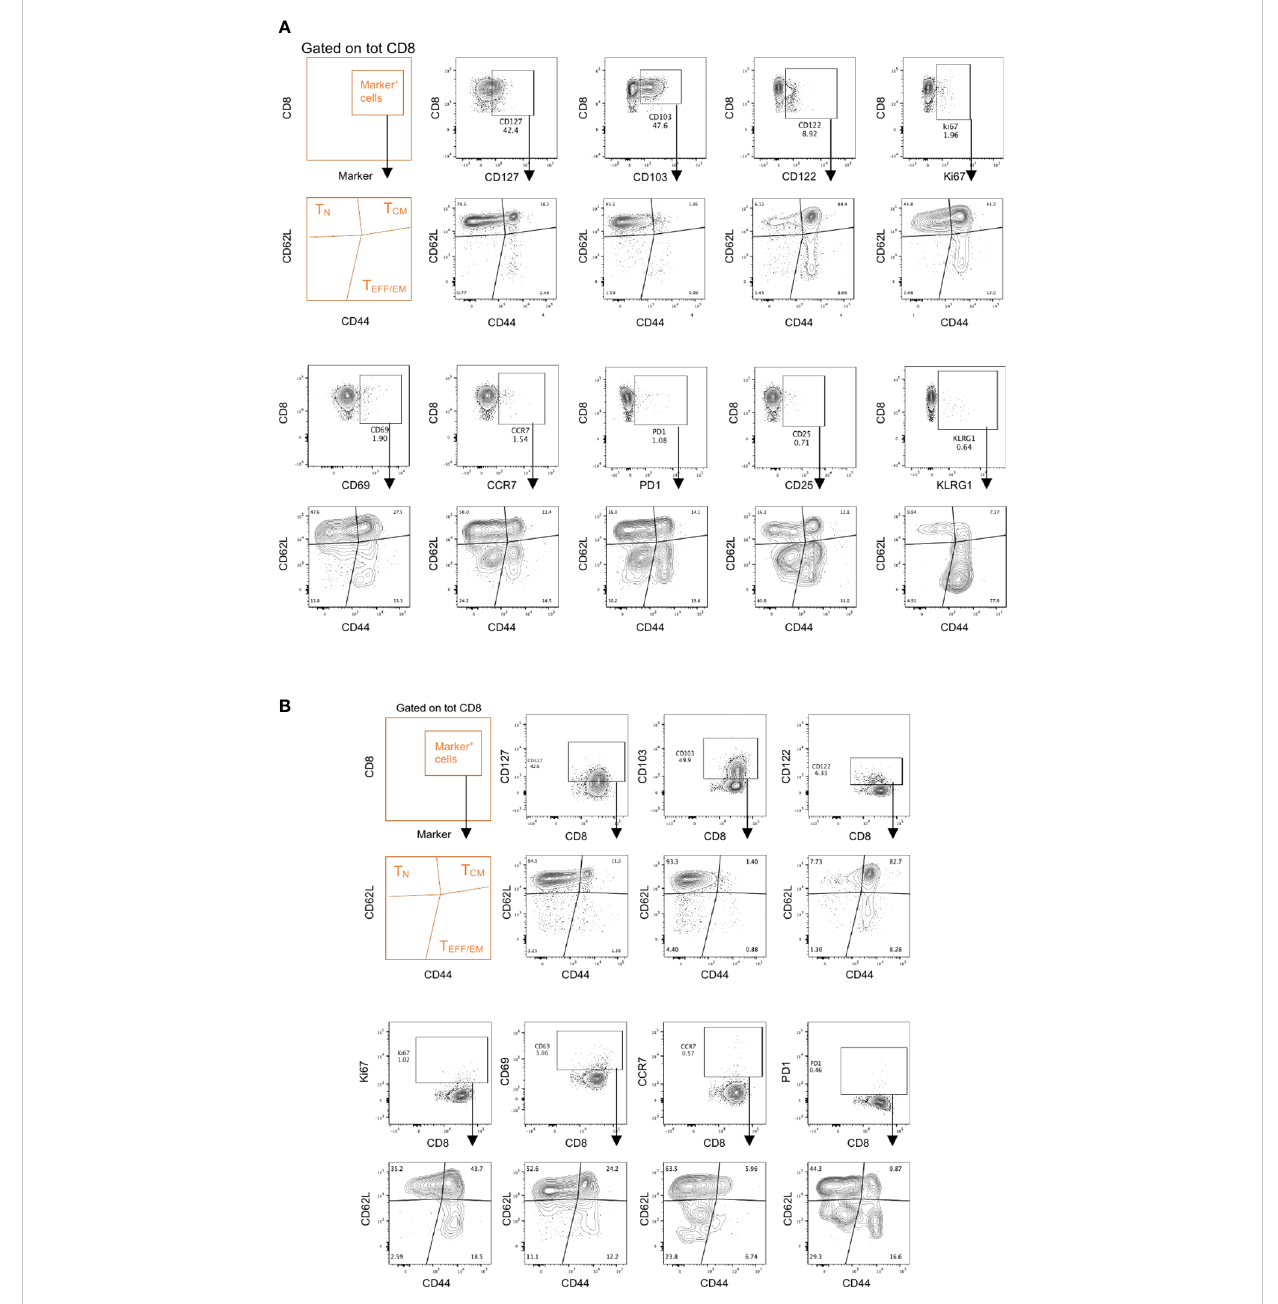
FIGURE 4 Memory effector phenotypes in Panel 2. Spleens and draining lymph nodes isolated from C57Bl/6 mice bearing YUMM UV 1.7 melanomas were processed and stained with Panel 2 as described in methods. (A, B) Representative analysis on CD8 + T cells from spleens (A) or tumor draining lymph nodes (B) where marker positive cells (top contour plots) are interrogated for their memory/effector phenotype (bottom contour plots) using the CD62L and CD44